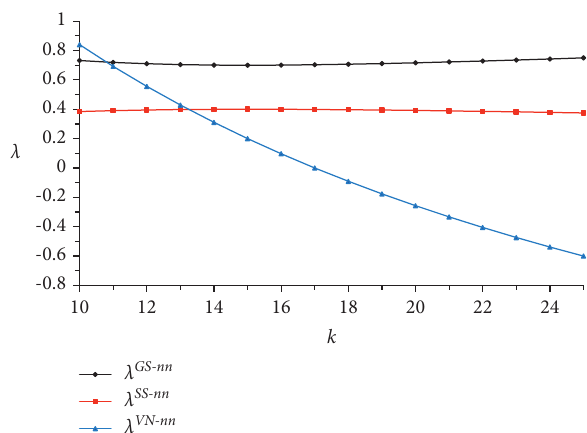
Figure 2: Effects of k on emission reduction revenue distribution